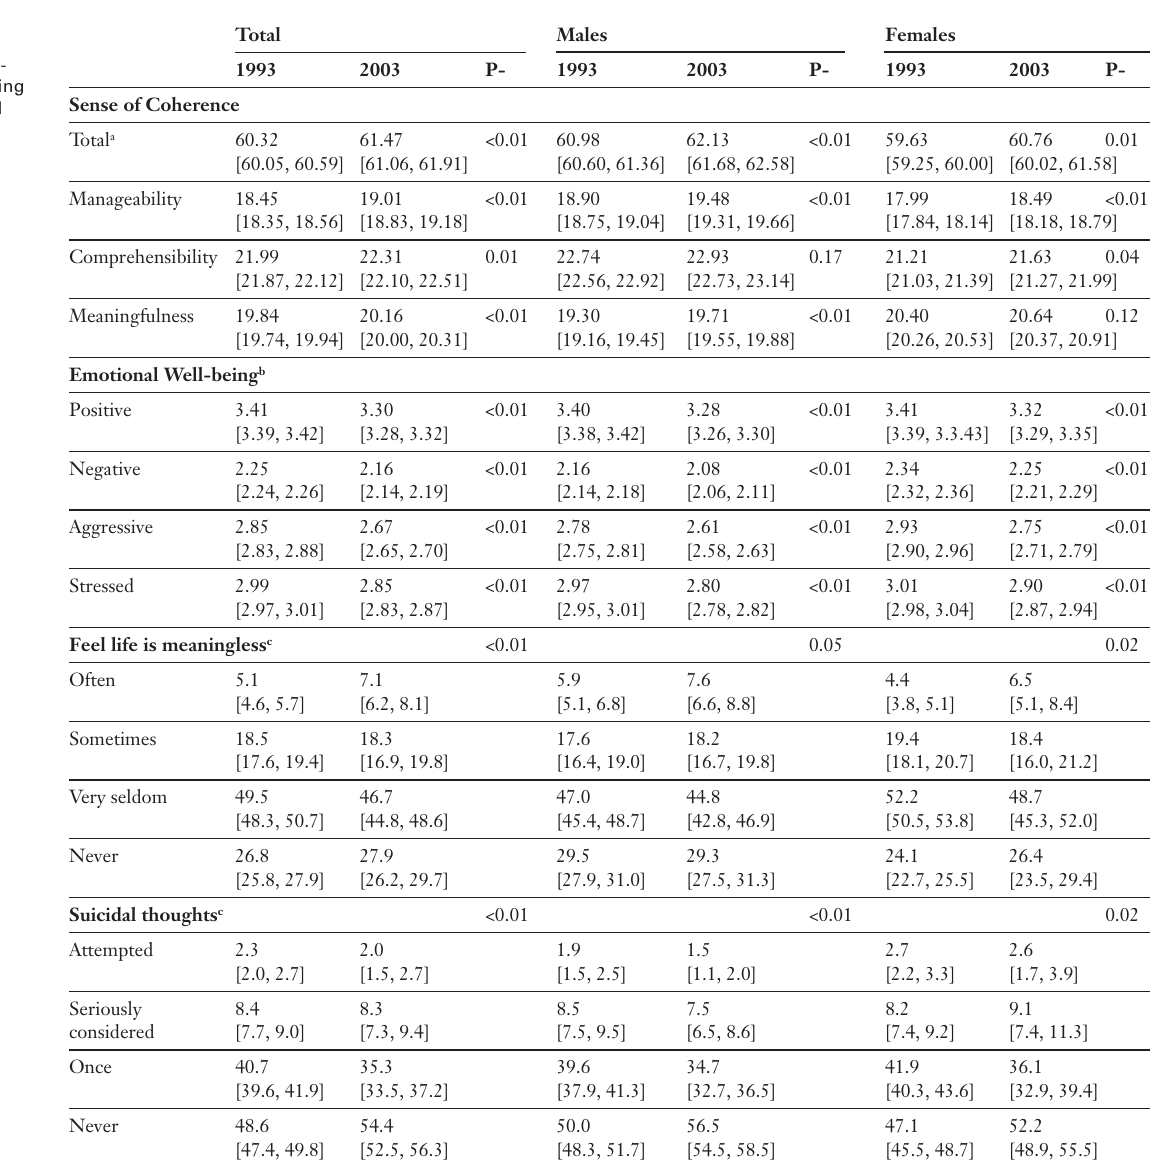
Table 4 Differences in Psy- chosocial Well-being between 1993 and